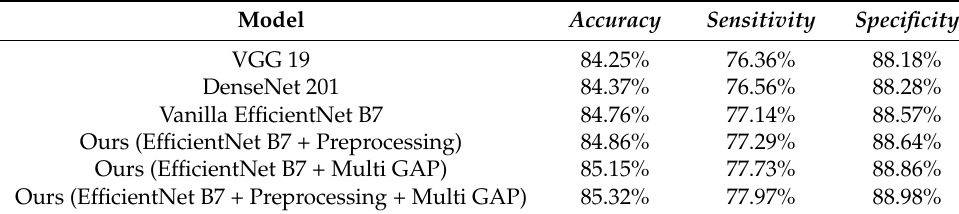
Table 11. Validation